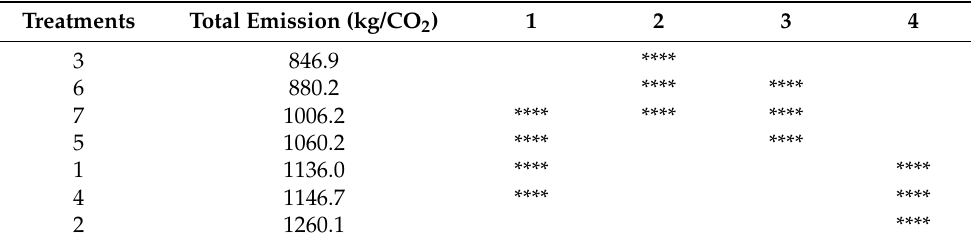
Table 8. Results of Tukey’s test for groups of the significantly homogeneous grouping factor (****) of biochar dose and soybean